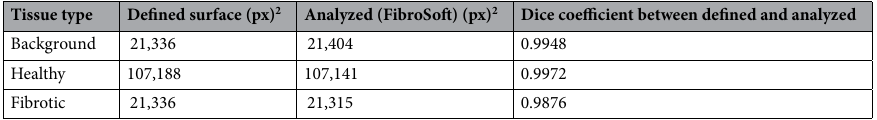
Table 3. Volume comparison by tissue